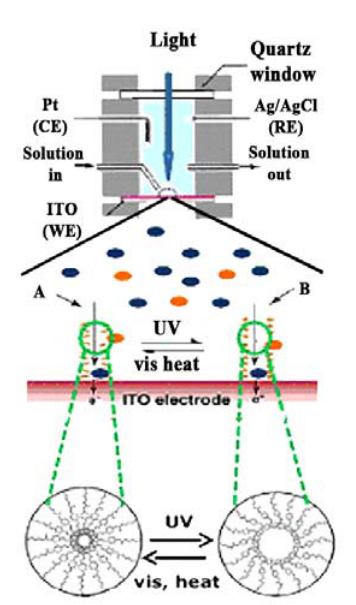
Figure10. Photo-responsive nanocomposites proposed in